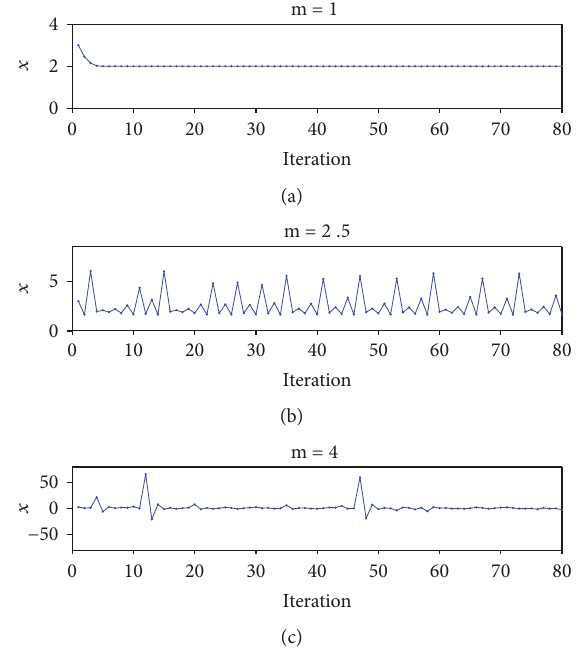
Figure 2: Sequences generated with a di ff erent degree coe ffi cient m for the guiding function f x = x x − 1 x − 2